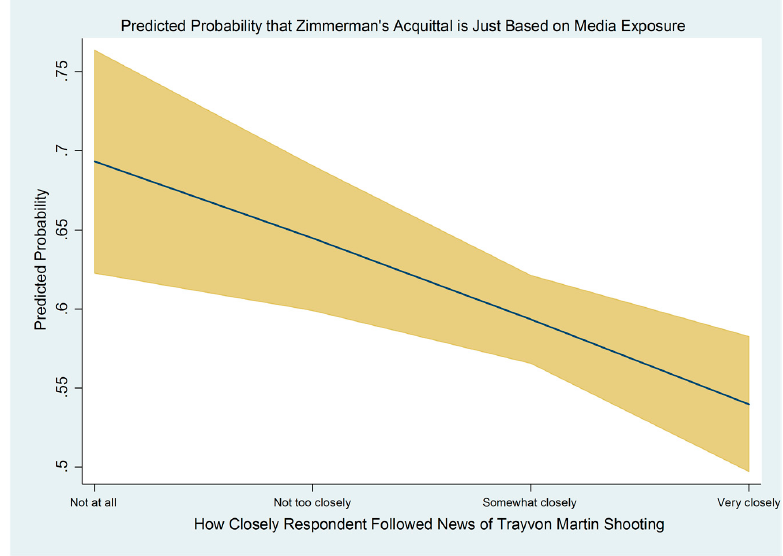
Figure 5. Perceptions that the Zimmerman Verdict was Just Based on Media Exposure.